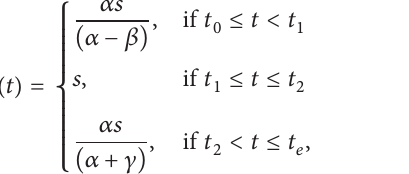
Substituting (1) and (5) into (4) and applying the equi- librium condition, 𝜕𝐶(𝑡)/𝜕𝑡 = 0 , we have the equilibrium departure rate as follows,